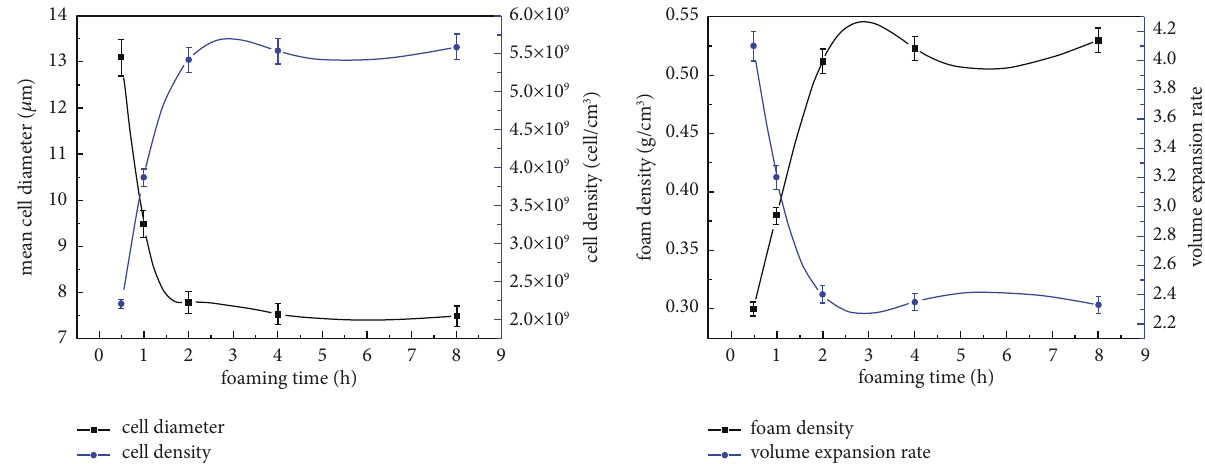
Figure 11: Effects of different incubation times on foaming of composites (110 ° C,